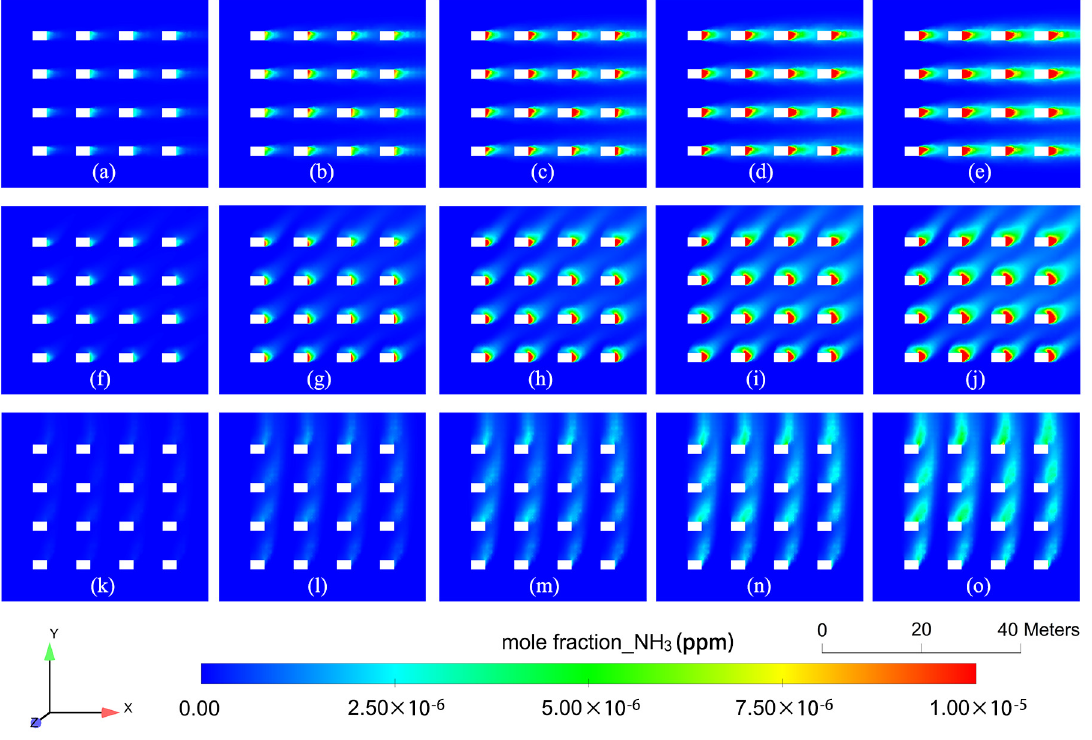
Figure 7. Ammonia mole fraction at 1.5 m above the ground in scenarios with 6 m intervals, in which the wind direction and outlet emission intensity are: ( a ) 0° and 10 ppm; ( b ) 0° and 30 ppm; ( c ) 0° and 50 ppm; ( d ) 0° and 70 ppm; ( e ) 0° and 90 ppm; ( f ) 45° and 10 ppm; ( g ) 45° and 30 ppm; ( h ) 45° 50 ppm; ( d ) 0 ◦ and 70 ppm; ( e ) 0 ◦ and 90 ppm; ( f ) 45 ◦ and 10 ppm; ( g ) 45 ◦ and 30 ppm; ( h ) 45 ◦ and and 50 ppm; ( i ) 45° and 70 ppm; ( j ) 45° and 90 ppm; ( k ) 90° and 10 ppm; ( l ) 90° and 30 ppm; ( m ) 90° 50 ppm; ( i ) 45 ◦ and 70 ppm; ( j ) 45 ◦ and 90 ppm; ( k ) 90 ◦ and 10 ppm; ( l ) 90 ◦ and 30 ppm; ( m ) 90 ◦ and and 50 ppm; ( n ) 90° and 70 ppm; ( o ) 90° and 90 ppm. 50 ppm; ( n ) 90 ◦ and 70 ppm; ( o ) 90 ◦ and 90